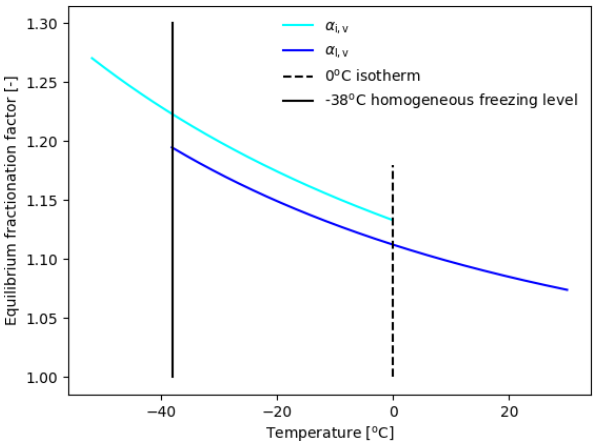
Figure A2. The difference between liquid and ice equilibrium frac- tionation factors. Inspired by Bolot et al. (2013) (their Fig.